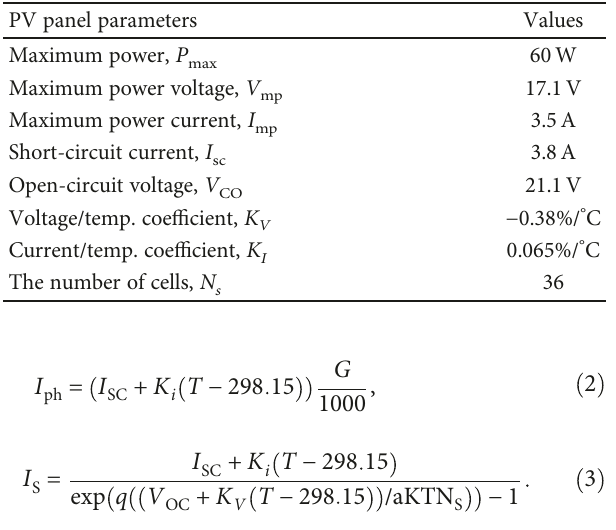
Figure 1: PV panel equivalent circuit. Table 1: Characteristics of MSX-60 PV panel at